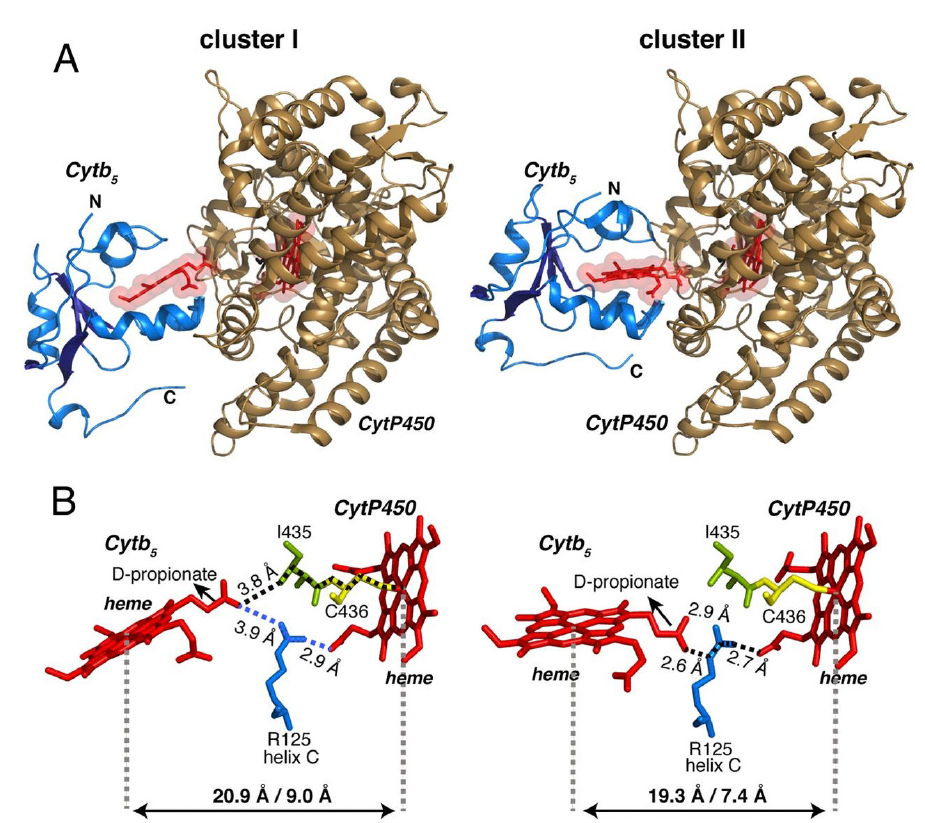
Figure 3. First high-resolution structure of the membrane-bound cytochromes-b5-P450 complex revealing electron transfer pathway. ( A ) Three-dimensional structure of the membrane-bound rabbit cytochrome P4502B4–cytochrome b complex reproduced from Ahuja 5 et al. 19 . It was obtained by using the high-resolution (solution- and solid-state) nuclear magnetic resonance (NMR) structure of membrane- bound rabbit cytochrome b (PDB code is 2M33), crystal structure of the soluble domain of cytochrome P4502B4 (PDB code is 1SUO), 5 and NMR and mutational constraints to obtain the structure of the membrane-bound complex. ( B ) Electron transfer pathway revealed by HARLEM 63 in the complex structure. PDB, Protein Data